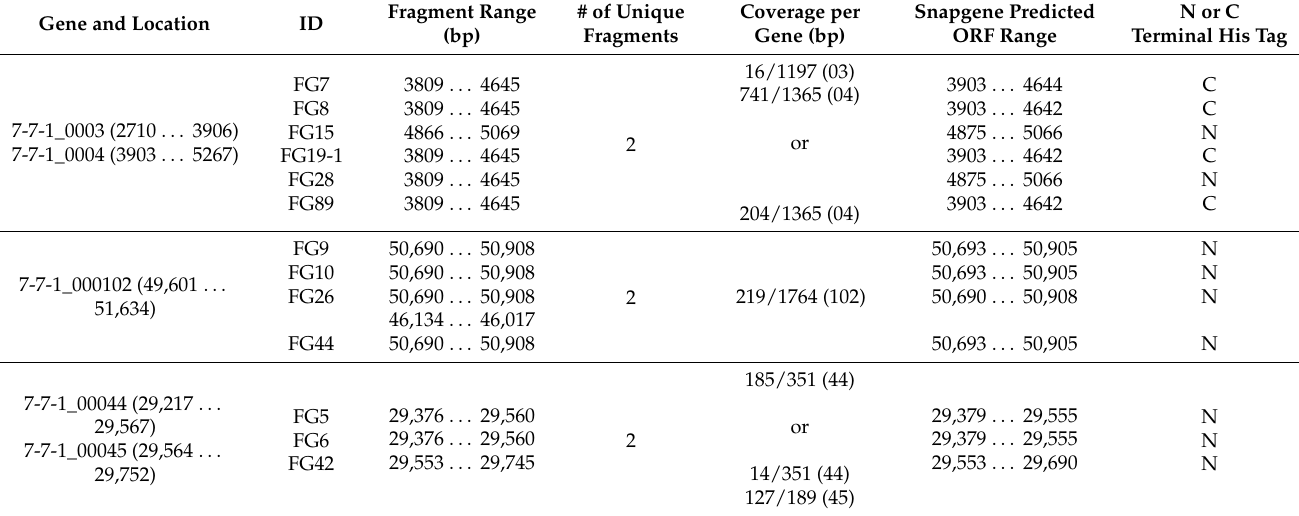
Figure 1. Illustration of RBP screening method. Transformants containing the phage genome library were lifted onto nitrocellulose membranes and protein expression was induced by placing on IPTG containing nutrient agar. Cells were lysed, membranes were blocked and washed prior to the addition of motile host cell bacteria. The membranes were washed to remove unbound host cells and then incubated at 30 ◦ C to allow for host cell growth. Transformants containing RBP encoding gene fragments were identified by comparing areas of host cell growth on membranes with original locations on master plate. Plasmids were isolated and sequenced. In silico analysis of sequences was used to identify genes coding for RBPs and predicting ORFs. Table 2. Mapping of DNA fragments to phage 7-7-1